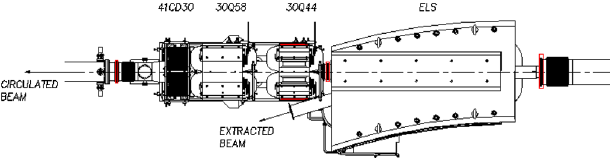
FIG. 1. (Color) ELS and quad assembly (courtesy of